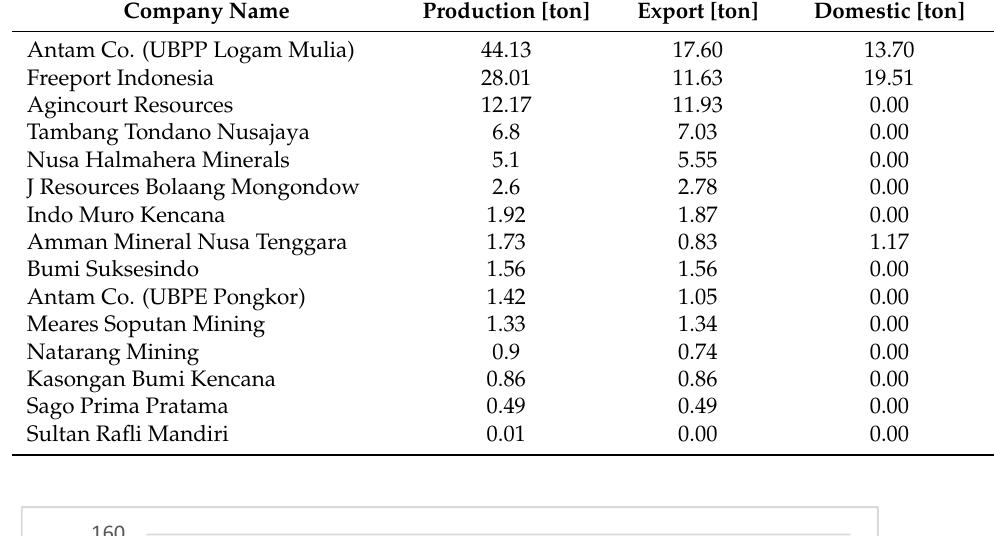
Table 2 . Top 15 Gold Companies.